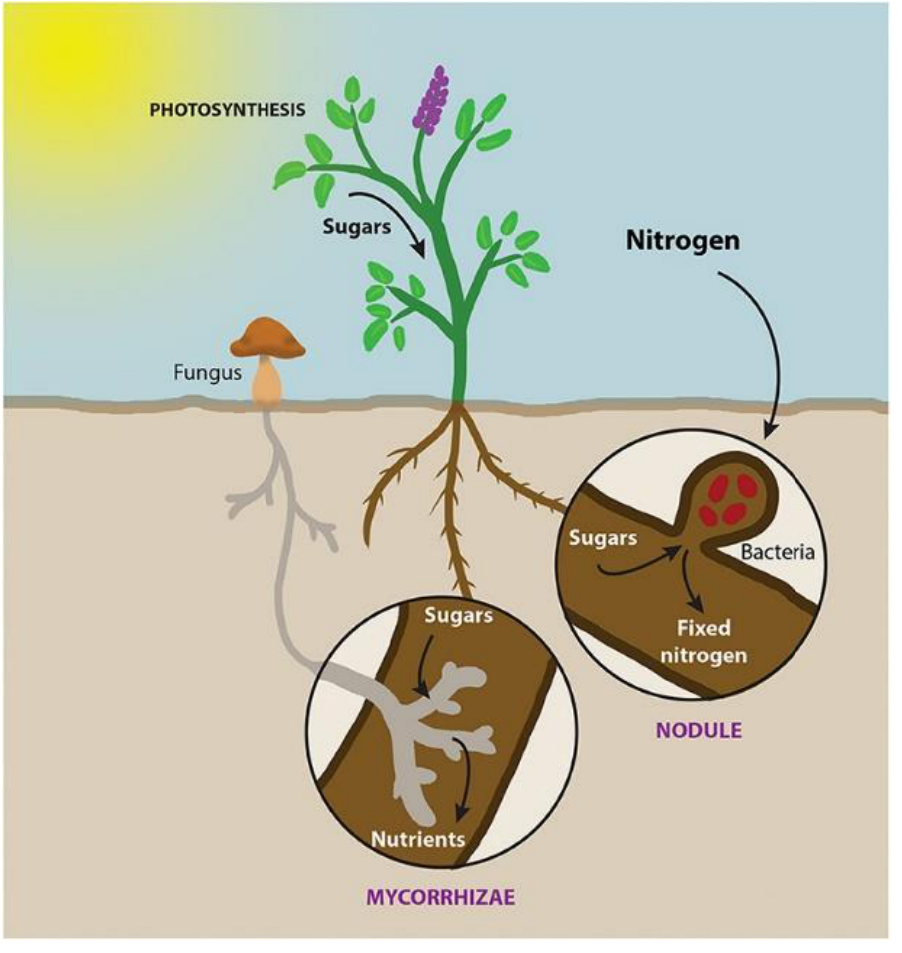
Figure 5. Symbiosis between plant roots and MN.